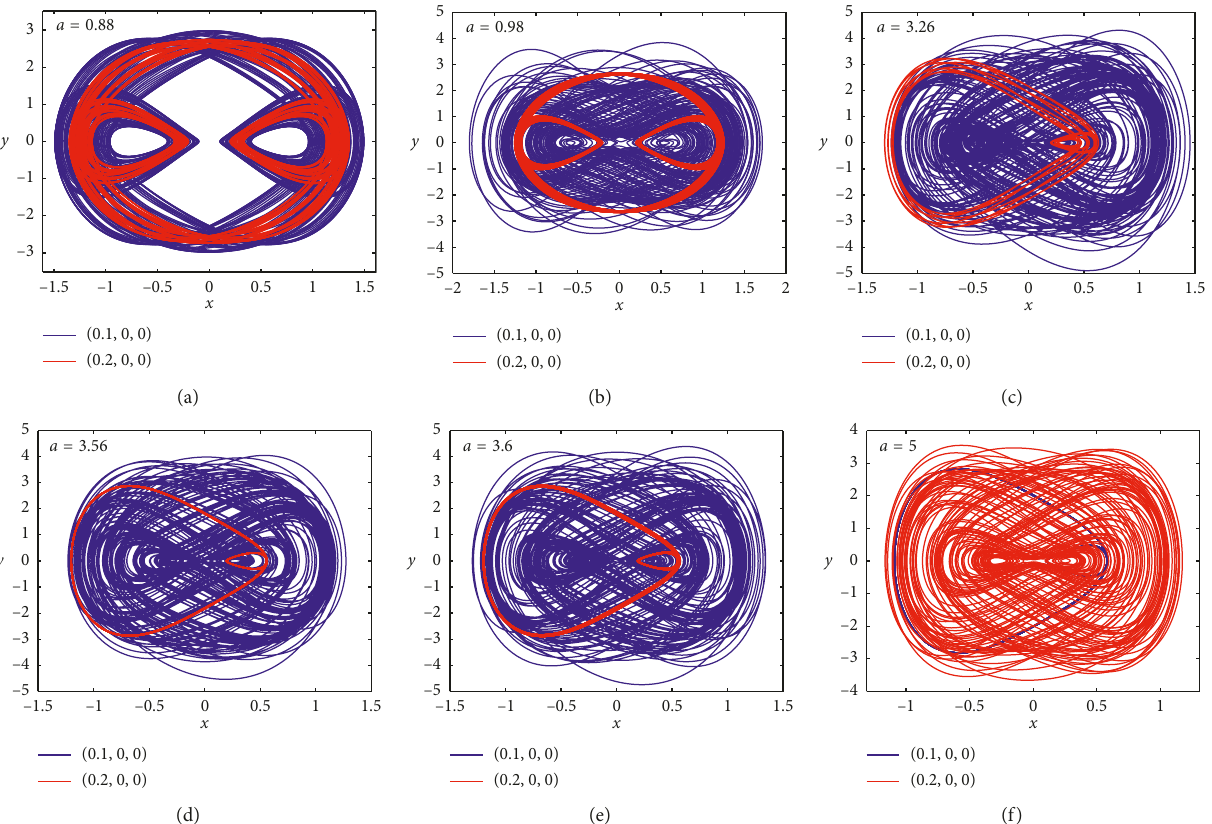
Figure 4: Coexistence of different attractors with different parameter a . (a) Quasiperiods with different shape; (b) chaos and quasiperiod; (c) chaos and complicated period; (d) chaos and period-1; (e) chaos and quasiperiod; (f) period and chaos, for the initial conditions (0.1, 0, 0) and (0.2, 0, 0),